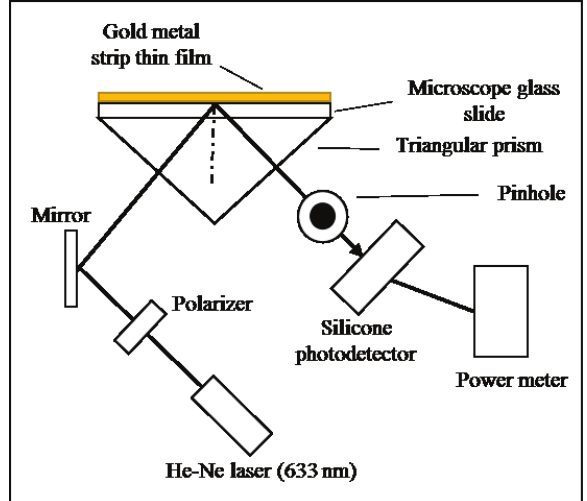
Fig. 4. Modified optical waveguiding assembly.